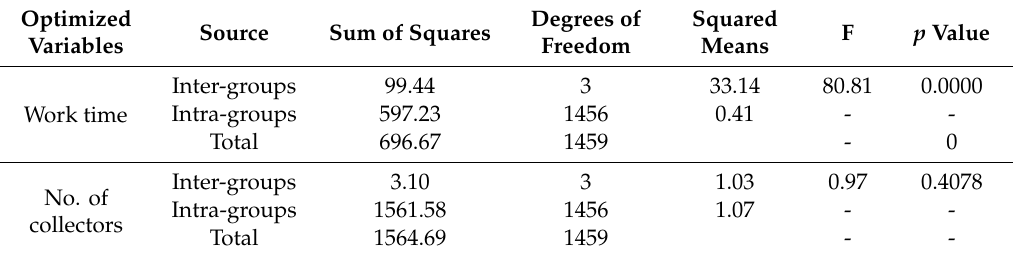
Table 8. ANOVA of the optimized datasets.